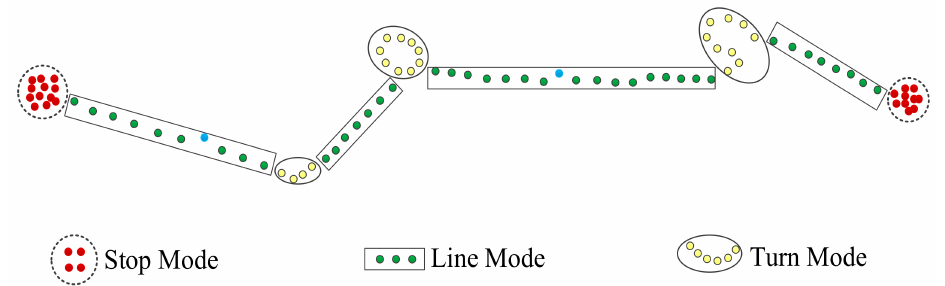
Figure 8. Three basic motion modes of a ship